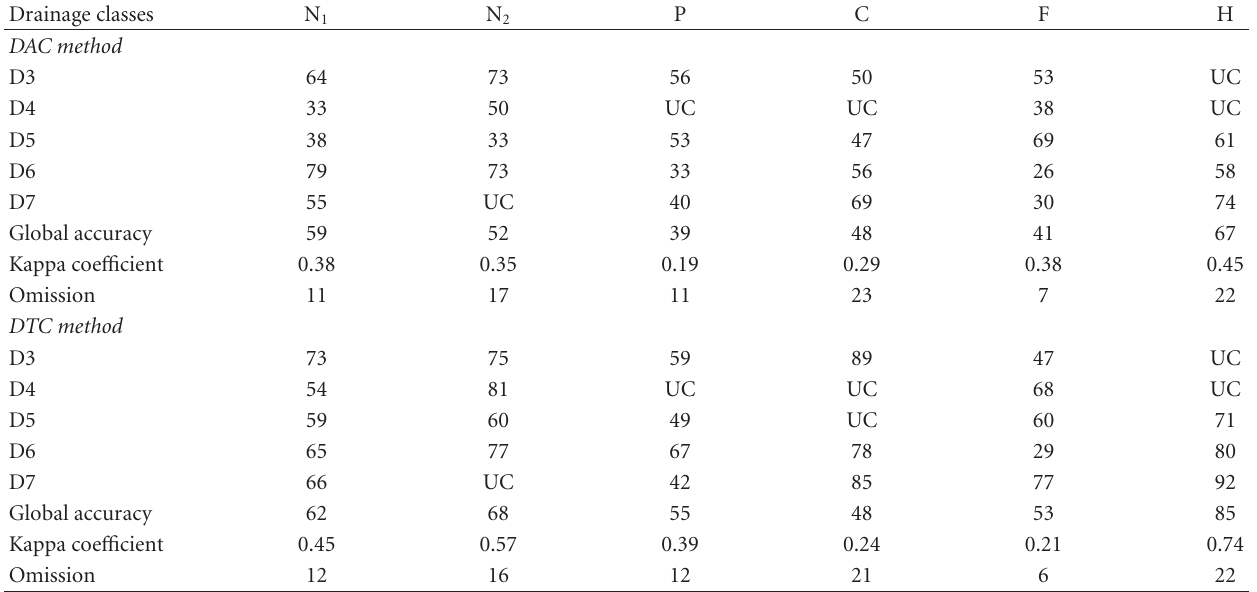
Table 8: Accuracy (%) assessment of soil drainage classification models (DAC and DTC) as function of drainage classes (rows) and land use